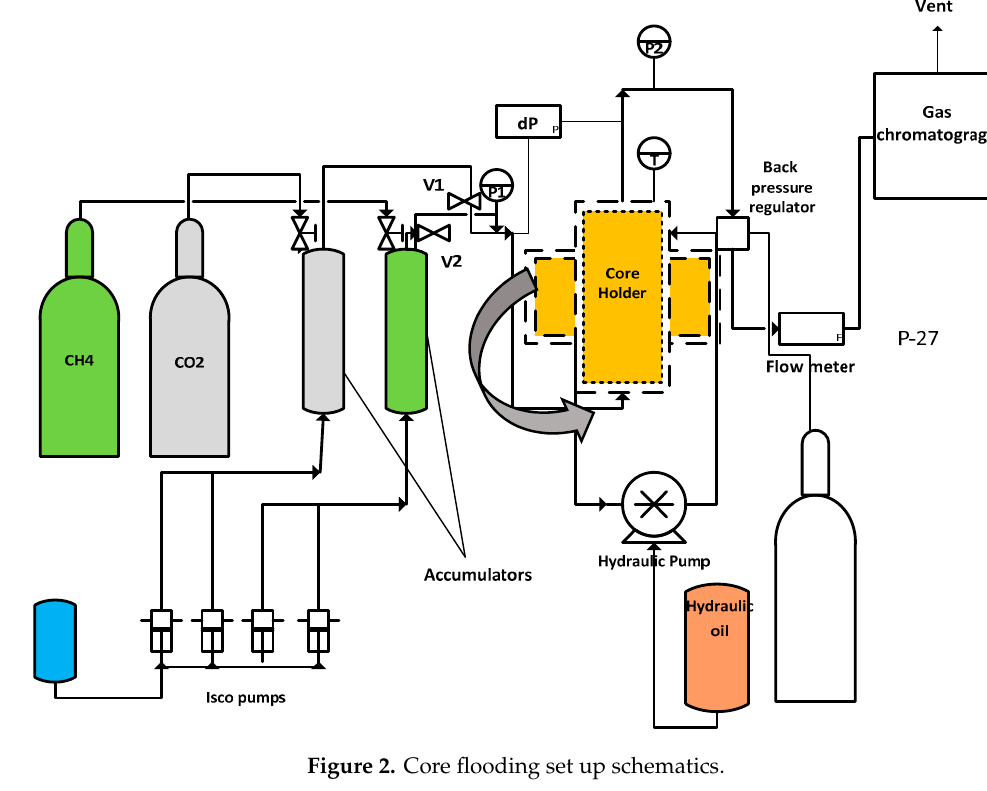
Figure 2. Core flooding set up schematics.